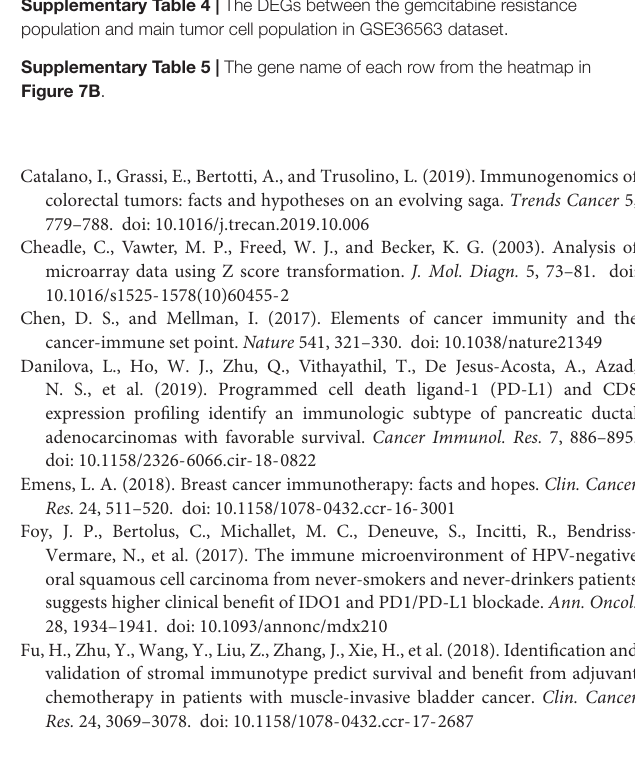
Supplementary Figure 1 | Univariate and multivariate Cox regression analysis of our immune signature and clinicopathological features in TCGA and Ruijin cohorts. Forest plots show HR and p value in (A,B) TCGA and (C,D) Ruijin cohorts. Supplementary Figure 2 | Pathways involved in the immunity-related 18-gene signature. The enrichment GO and KEGG pathway analyses of DEGs in (A) TCGA, (B) ICGC AU, (C) ICGC CA databases. Supplementary Figure 3 | Low score/PD-L1( + ) PDAC showed inferior prognosis. Kaplan-Meier survival curves of PD-L1 expression in all patients, the low score group, and the high score group in (A) ICGC CA ( n = 115) and (B) ICGC AU ( n = 68), and (C) GSE57495 ( n = 63). (D) PD-L1 expression between the low score and the high score group in TCGA, ICGC CA, ICGC AU, GSE57495, and Ruijin cohorts (TCGA: p = 0.18; ICGC CA: p = 0.16; ICGC AU: p = 0.78; GSE57495: p = 0.24; Ruijin: p = 0.16). Supplementary Figure 4 | Prognosis analysis of TIM3 and CTLA4 in ICGC CA, ICGC AU, and GSE57495 cohorts. Kaplan-Meier survival curves of TIM3 expression in all patients, or by subgroup analysis based on our immune signature in (A) ICGC CA ( n = 115) and (B) ICGC AU ( n = 68), and (C) GSE57495 ( n = 63). Kaplan-Meier survival curves of CTLA4 expression in all patients, or by subgroup analysis based on our immune signature in (D) ICGC CA ( n = 115) and (E) ICGC AU ( n = 68), and (F) GSE57495 ( n = 63). Supplementary Table 1 | The 1308 immunity-related genes obtained by Cox univariate analysis. Supplementary Table 2 | The risk score formula of immune-related 18-gene signature. Supplementary Table 3 | Sequences of the qRT-PCR primers used in this study.